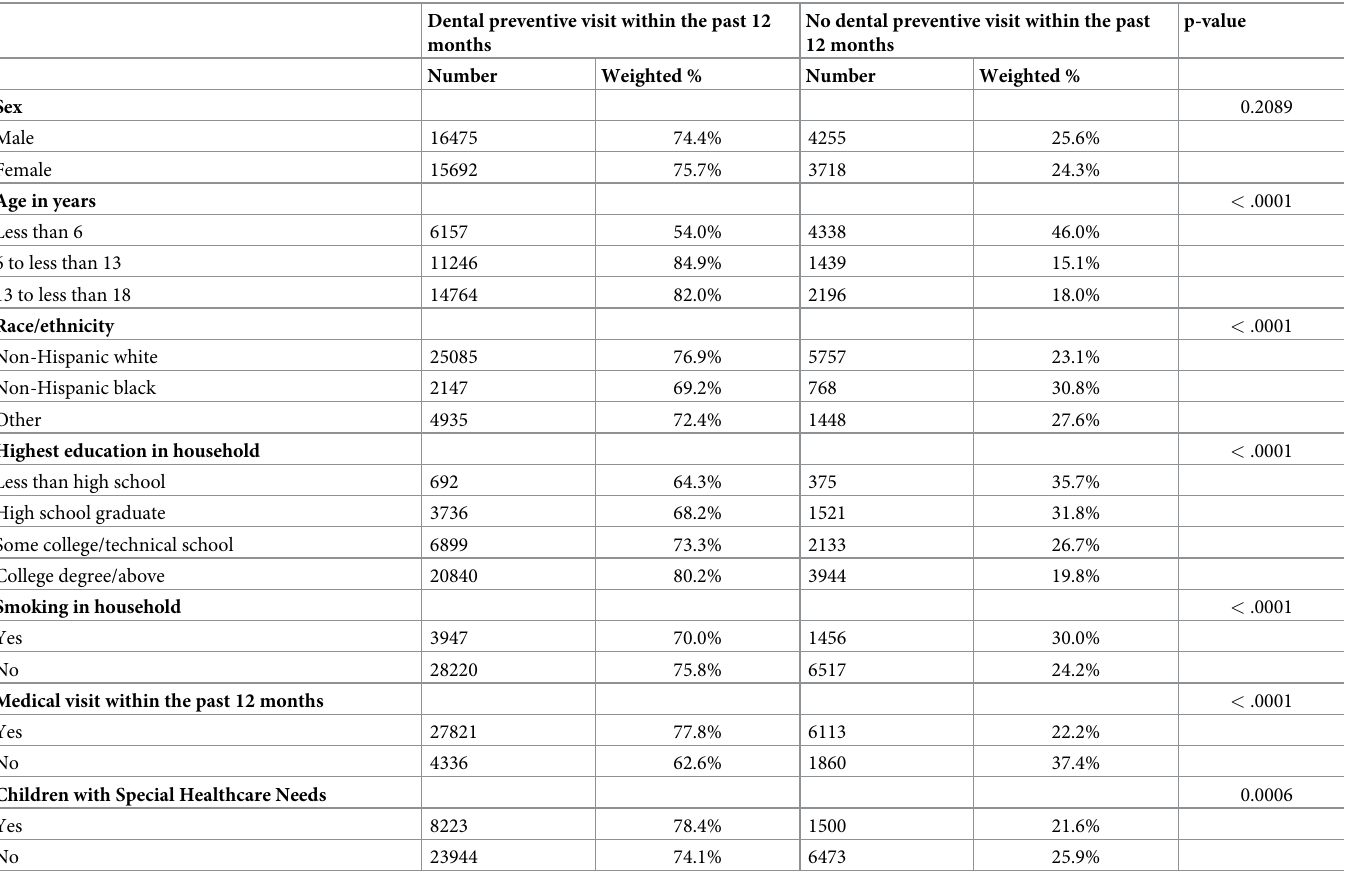
Table 2. Bivariate analyses of the outcome, dental preventive visits within the past 12 months, and variables of interest, national survey of children’s health,